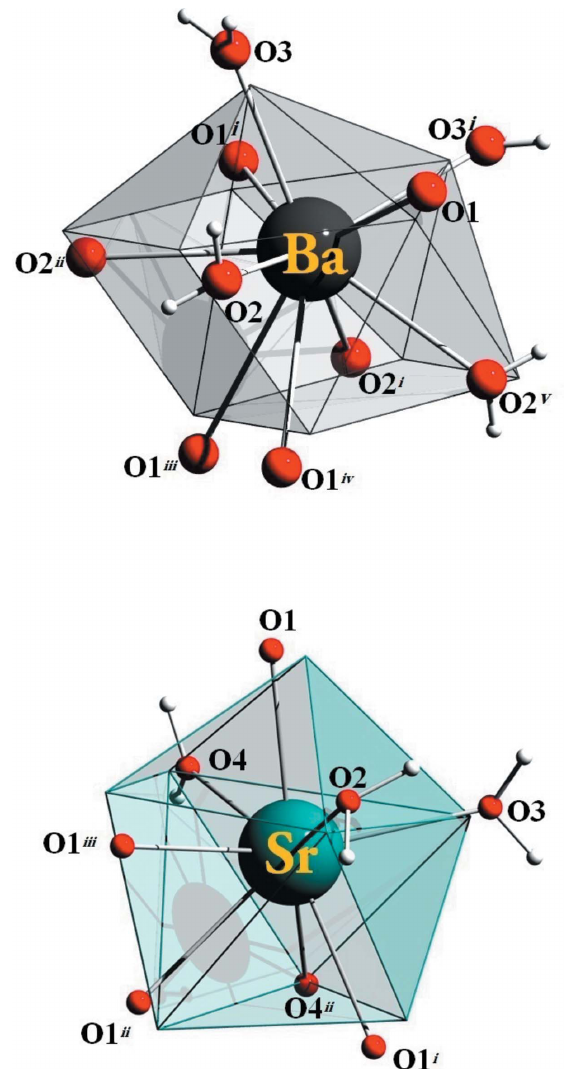
Figure 2 Coordinating polyhedra of compounds (I) and (II), the colored polyhedra (cid:4) y , z ; with open front faces represent the ideal polyhedral shape as calculated 2 (cid:4) y , z ; (ii) 1 (cid:4) x , y , z ; (cid:4) z ; by SHAPE 2.1 [Symmetry codes for (I): (i) 1 (cid:4) x , 1 + x , y , 1 2 2 2 (cid:4) y , 1 (cid:4) z ; (iv) 3 (cid:4) x , y , 1 (cid:4) z ; (v) x , 1 (cid:4) y , z ; and for (II): (i) (iii) (cid:4) 1 + x , 1 2 2 2 2 2 2 (cid:4) x , y , 1 (cid:4) z ; (iii) (cid:4) 1 (cid:4) z .] 2 (cid:4) x , y , z ; (ii) 5 + x , y , 1 2 2 2 2